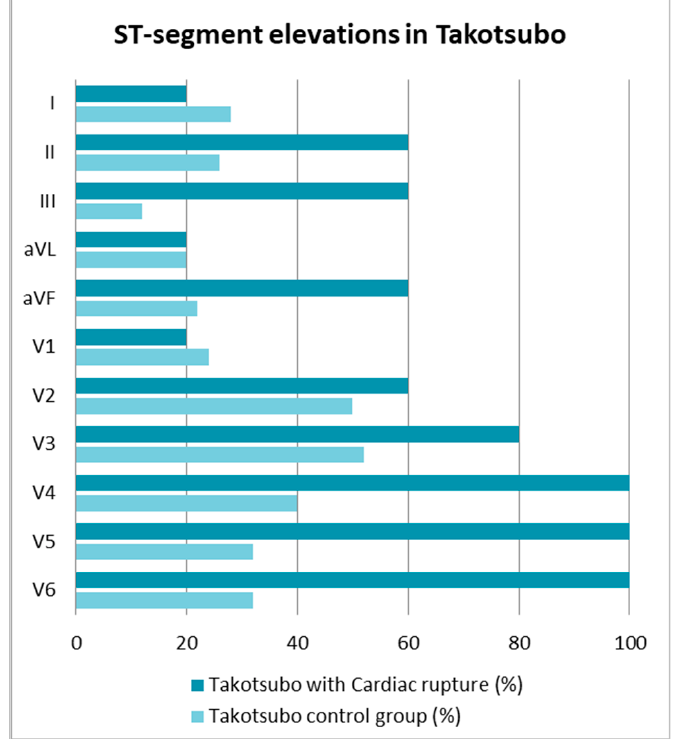
Figure 1. Comparison of ST segment elevations in the TS groups. Table 2. ST segment elevations in patients with Takotsubo syndrome and cardiac rupture.